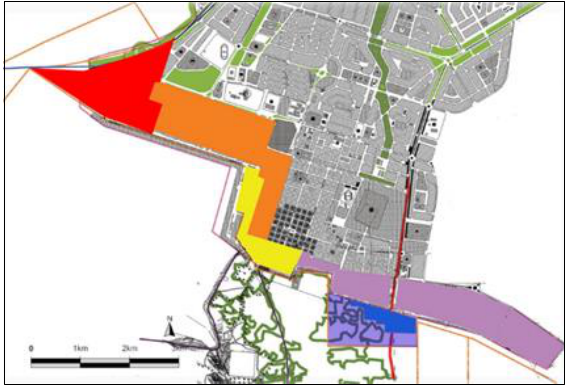
Figure (16 )The suggested area an additional changes Also the transitional zone between the city and the archaeological site is very sensitive area adjacent to the archaeological site and to the oasis part (1994). But that area is under the pressure of a large development where the proposal of strict controls and FRACTIOUS the type and size of the development in this region because it directly overlooking the archaeological site of the organizational outline, so it is proposed not to increase the number of floors of the buildings more than 4-storey building.